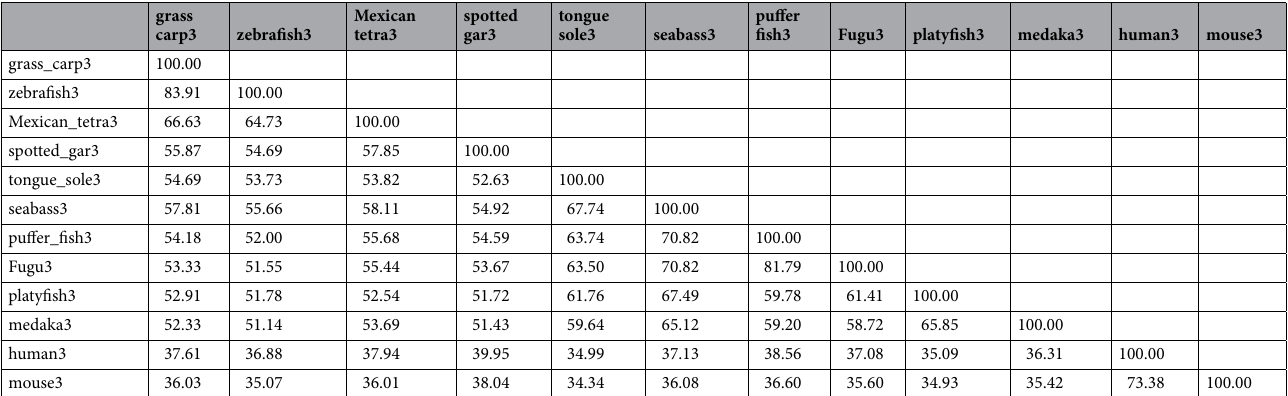
Table 2. Amino acid sequence identities of T1R3 compared with other fish and mammals. Amino